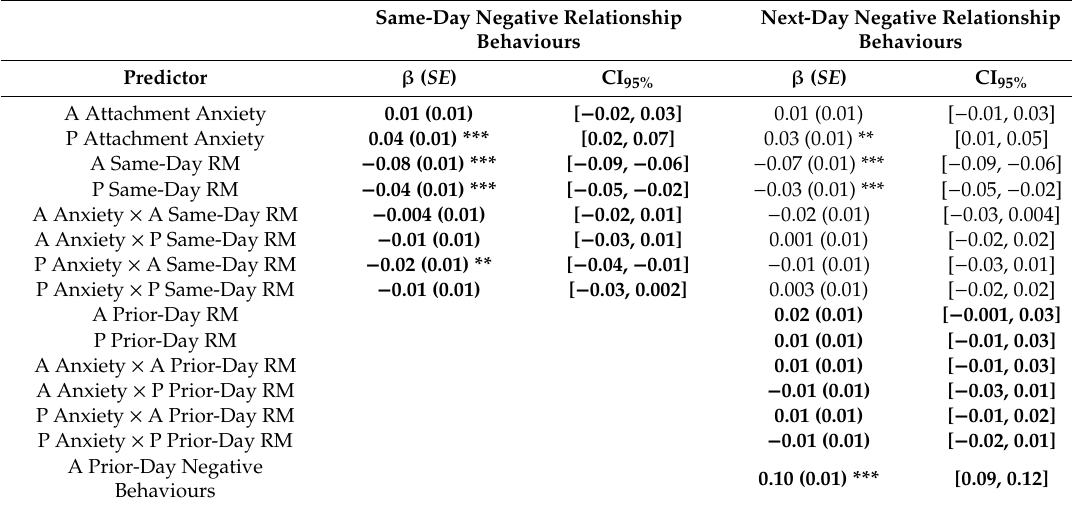
Table 2. Associations of attachment anxiety and daily relationship mindfulness with same-day and next-day negative relationship behaviours.